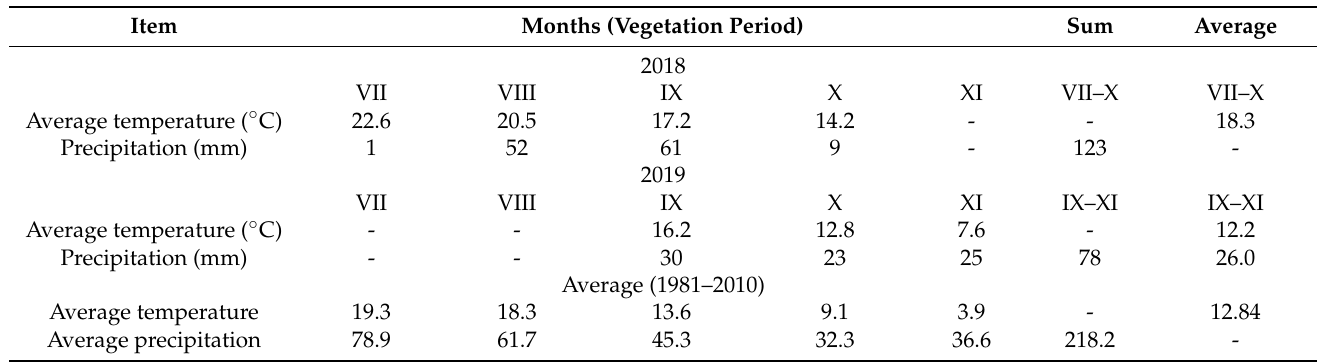
Table 1. Weather conditions during the experiment conducted in 2018 and 2019 (Prudnik,